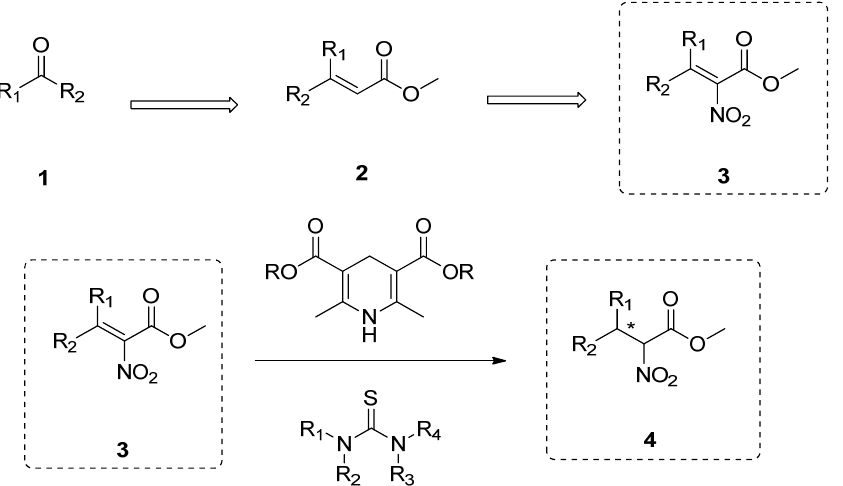
Figure 1. Synthetic approach for the synthesis of tetrasubstituted nitroalkenes and their enantioselec- tive catalytic reduction.